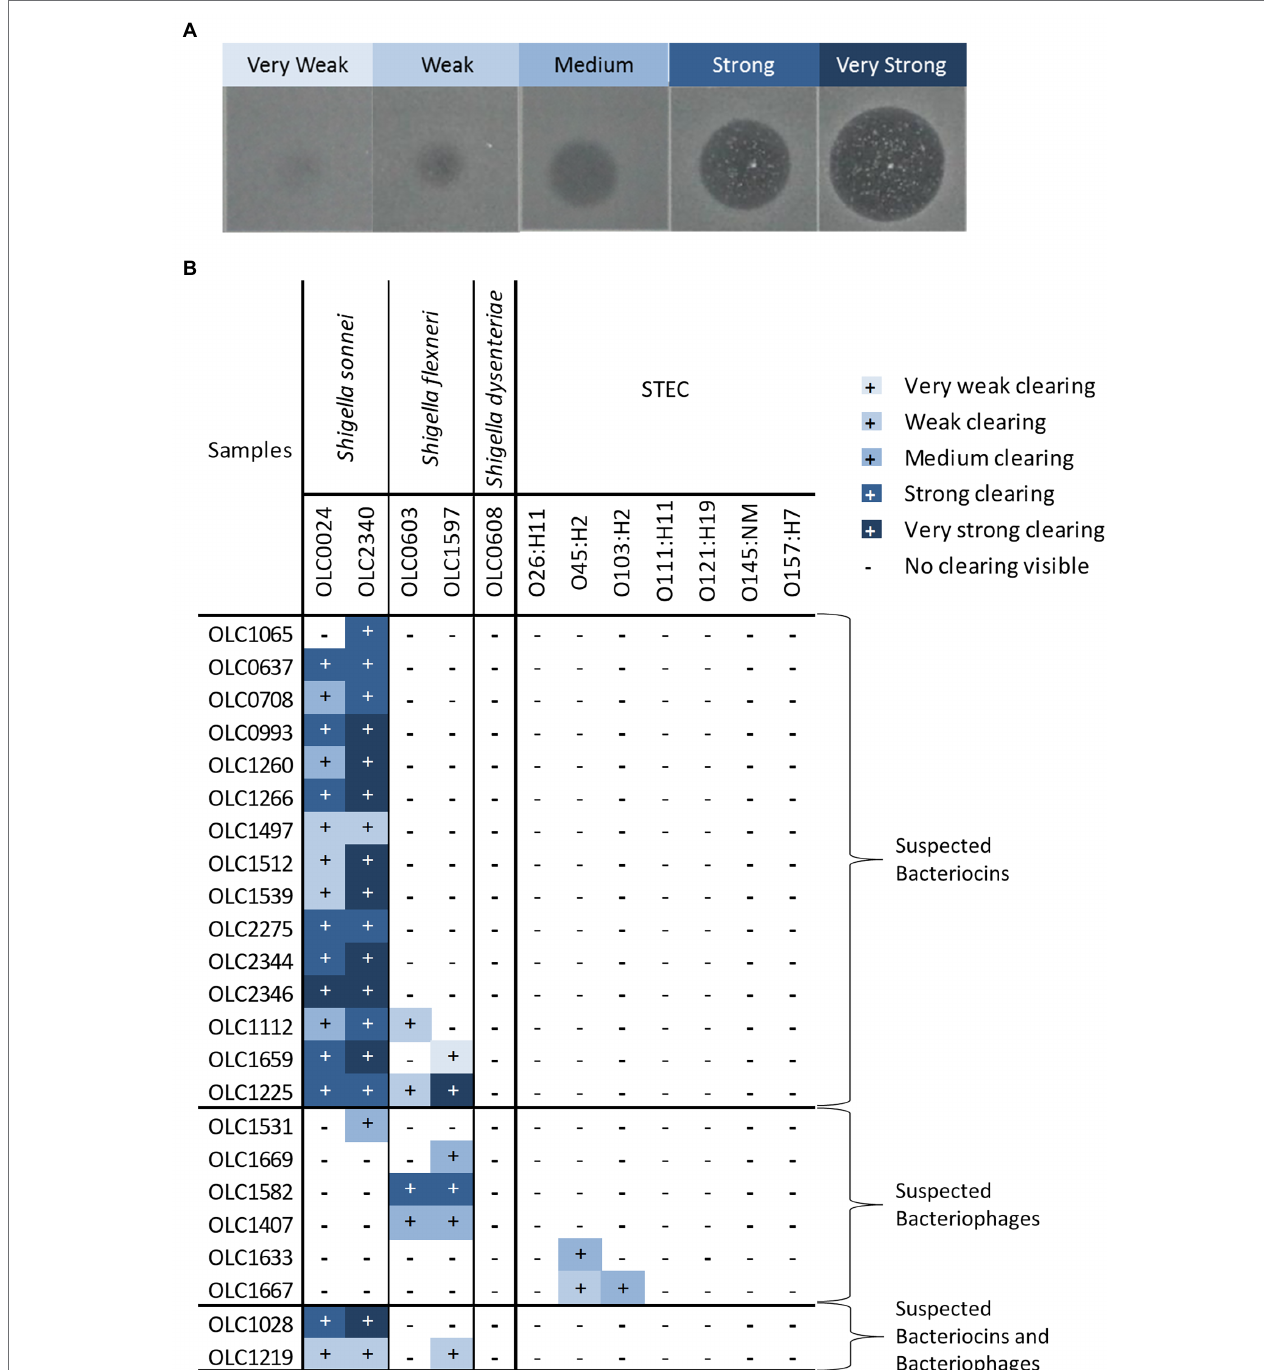
FIGURE 3 | Strengths of inhibitory activity of bacterial strains. (A) Representative image of the different strengths of the inhibitory activity observed in the strains used in this study. Level of activity (e.g., very weak to very strong) was classified based on diameter of the zone of clearing and opacity of the spot. (B) Relative strength of inhibitory activity of cell-free extracts from bacterial strains on Shigella spp. and STEC is indicated. The strains are grouped based on predicted inhibitor present in the sample (bacteriocins, bacteriophage, or